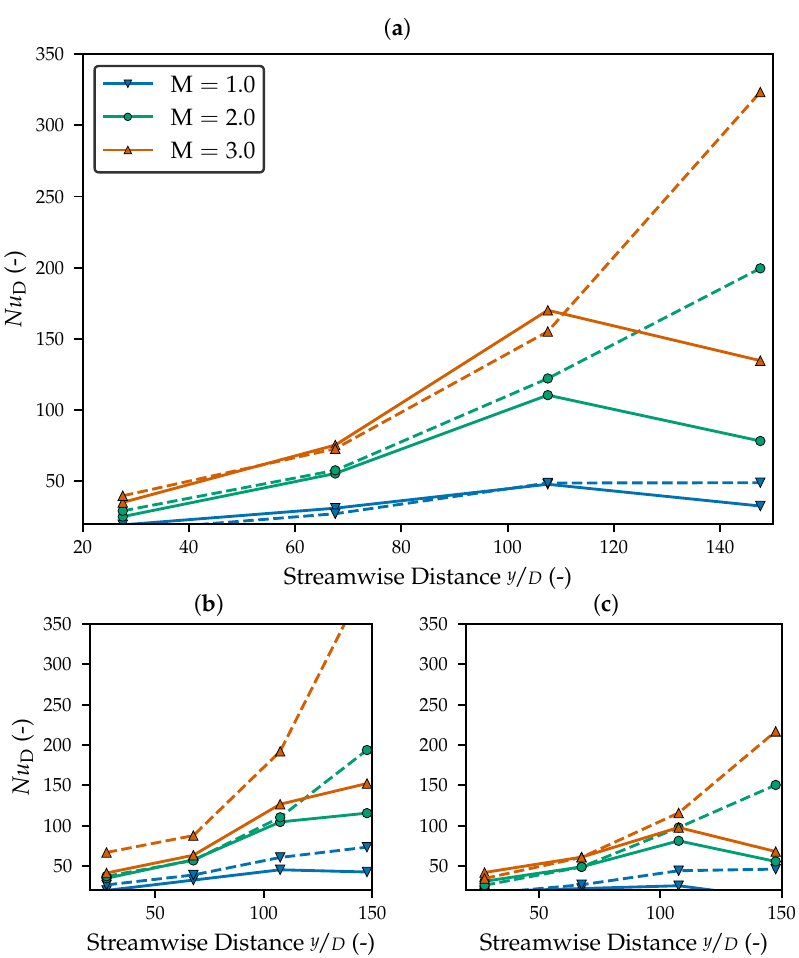
Figure A1. Nusselt numbers over streamwise length on the cavity side of the effusion specimen averaged in the imp area. ( a ) Nominal cavity height 5 D at top, ( b ) small cavity height 3 D bottom left, ( c ) large cavity height 7 D bottom right. Solid lines show aligned setup MALO00 ; dashed lines show misaligned setup MALO05